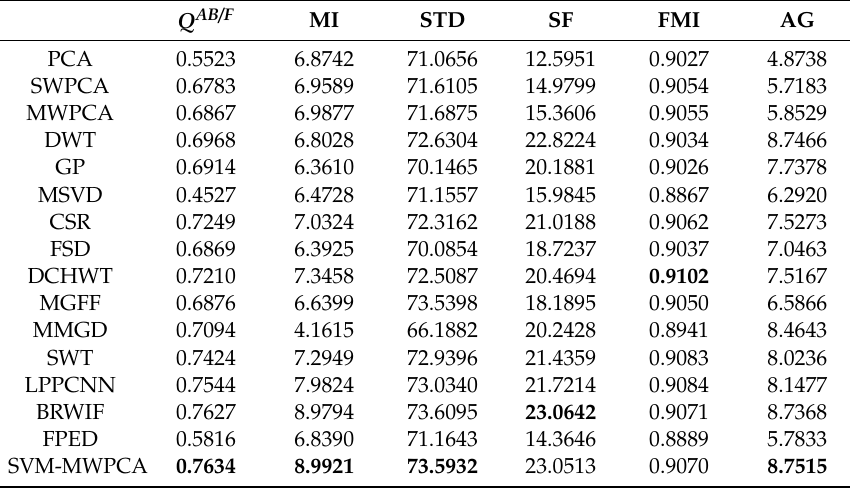
Table 6. Evaluation indexes of the fused images in source image pair